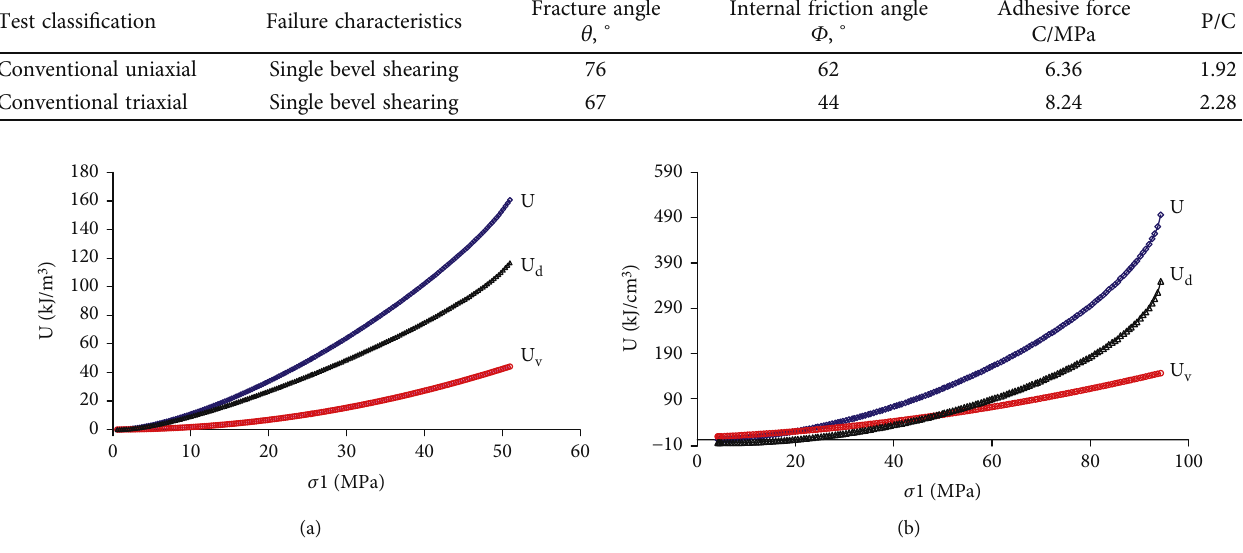
Figure 5: Comparison of energy and axial stress curves. (a) Uniaxial compression failure energy curve. (b) Triaxial compression failure energy curve.